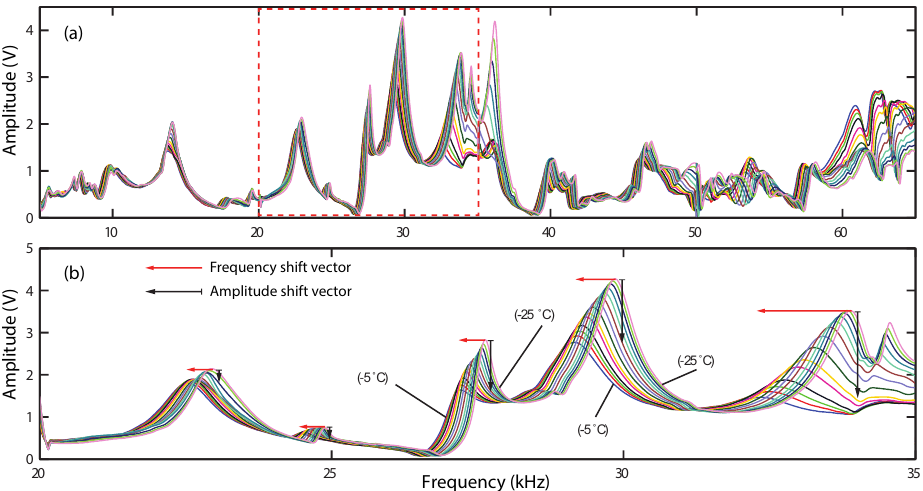
Figure 4. Resonant spectrum of our standard ice sample as a function of temperature (a). The range outlined by the red border is displayed in (b).